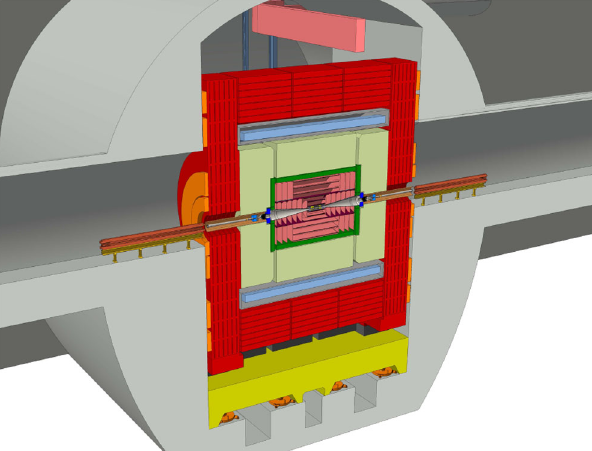
FIG. 3. Vertical cut through the new detector model CLICdet allowing QD0 to be located outside of the experiment. No preinsulator or QD0 shielding are needed as opposed to the short L (cid:1) design in Fig. 1 [14].